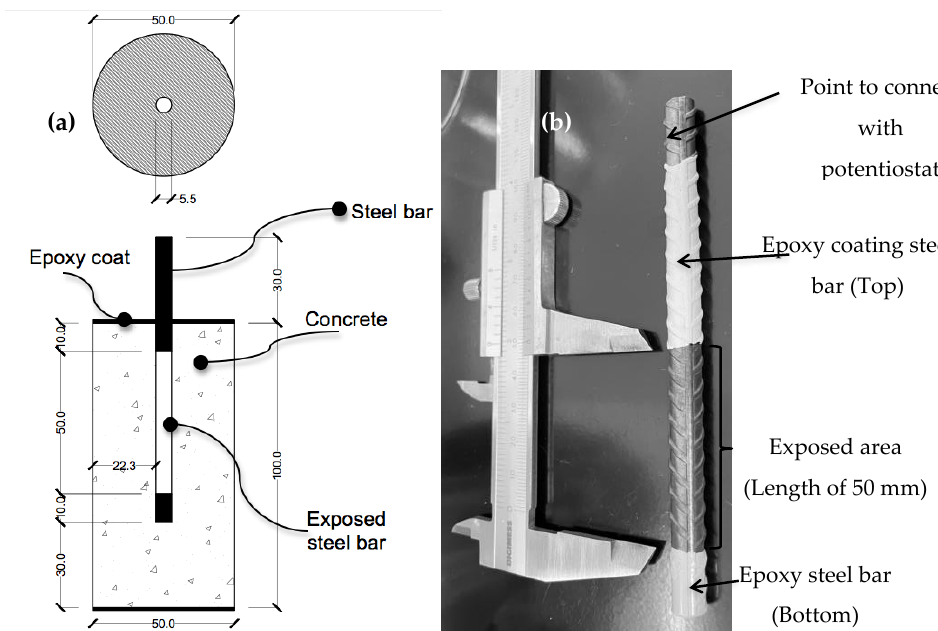
Figure 1. ( a ) Experimental representation of the embedded steel bar for electrochemical corrosion behavior in stagnant and naturally aerated 0.5 M NaCl at 25 (±3) °C. Dimensions are in millimeters. ( b ) A typical steel bar coated with epoxy before embedding into the concrete used in experiments.